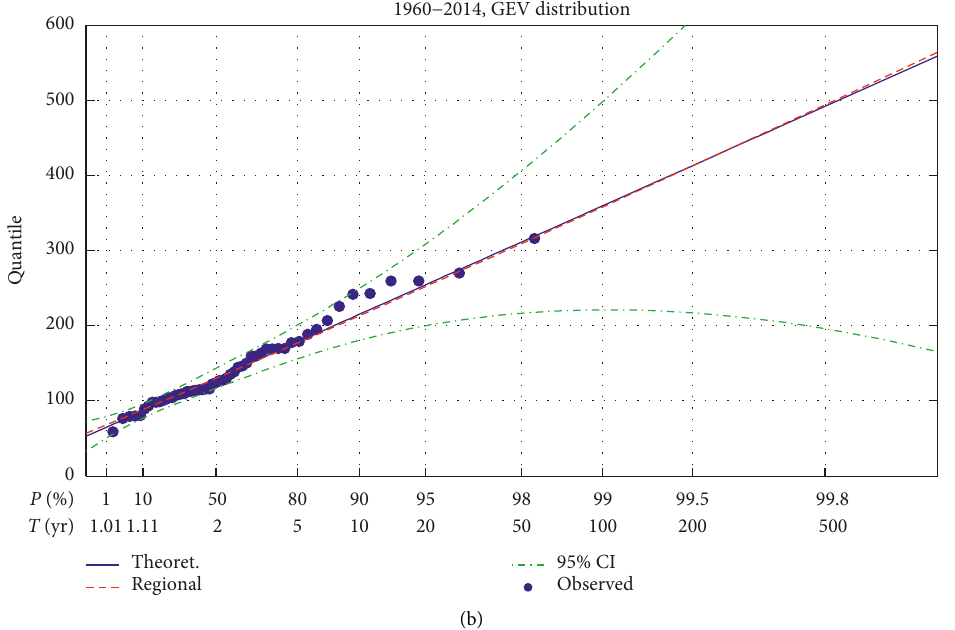
Figure 8: (a) Comparison of fitting curves of GEV, P-III, and GPAR. (b) Observed and estimated PX5D in Xihua station based on regional and at-site methods.